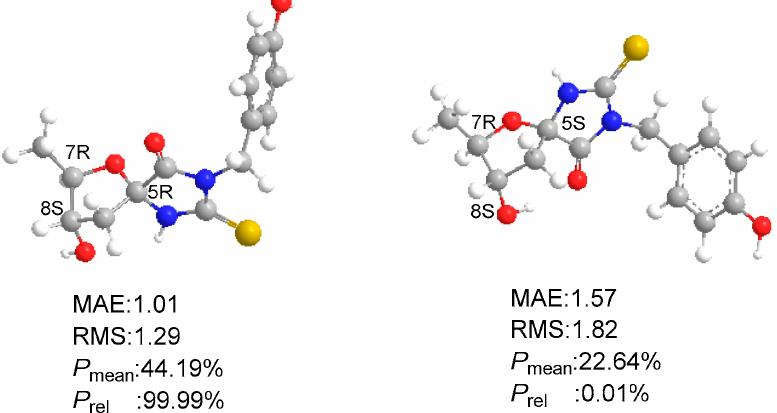
Figure 3. The 13 C NMR chemical shift calculation results of a pair of C-5 epimers of (5 R , 7 R , 8 S ) − 1 ( 1a ) and (5 S , 7 R , 8 S ) − 1 ( 1b ). ECD calculations were carried out to define the absolute configuration of 1 . As shown in Figure 4, the calculated ECD curve matched well with the experimental data, enabling a confident assignment of the absolute configuration of (5 R ,7 R ,8 S ) − 1 .